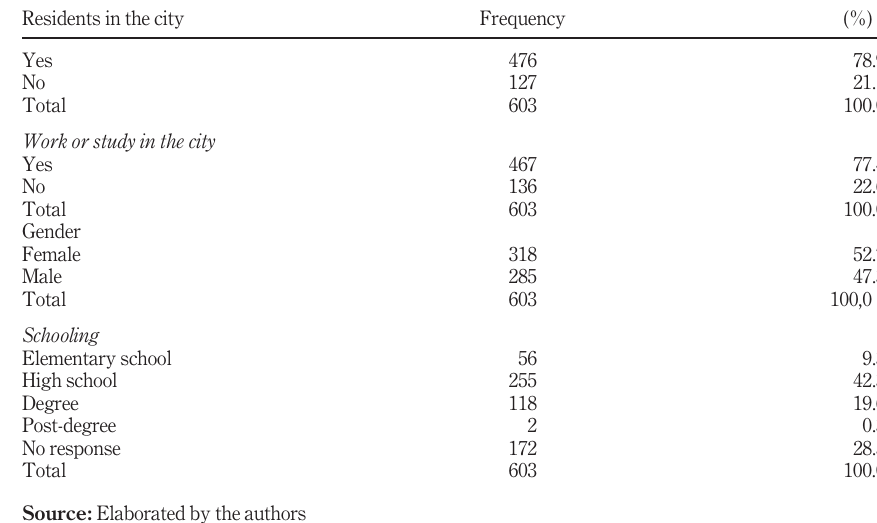
Table II. Respondents ’ pro fi